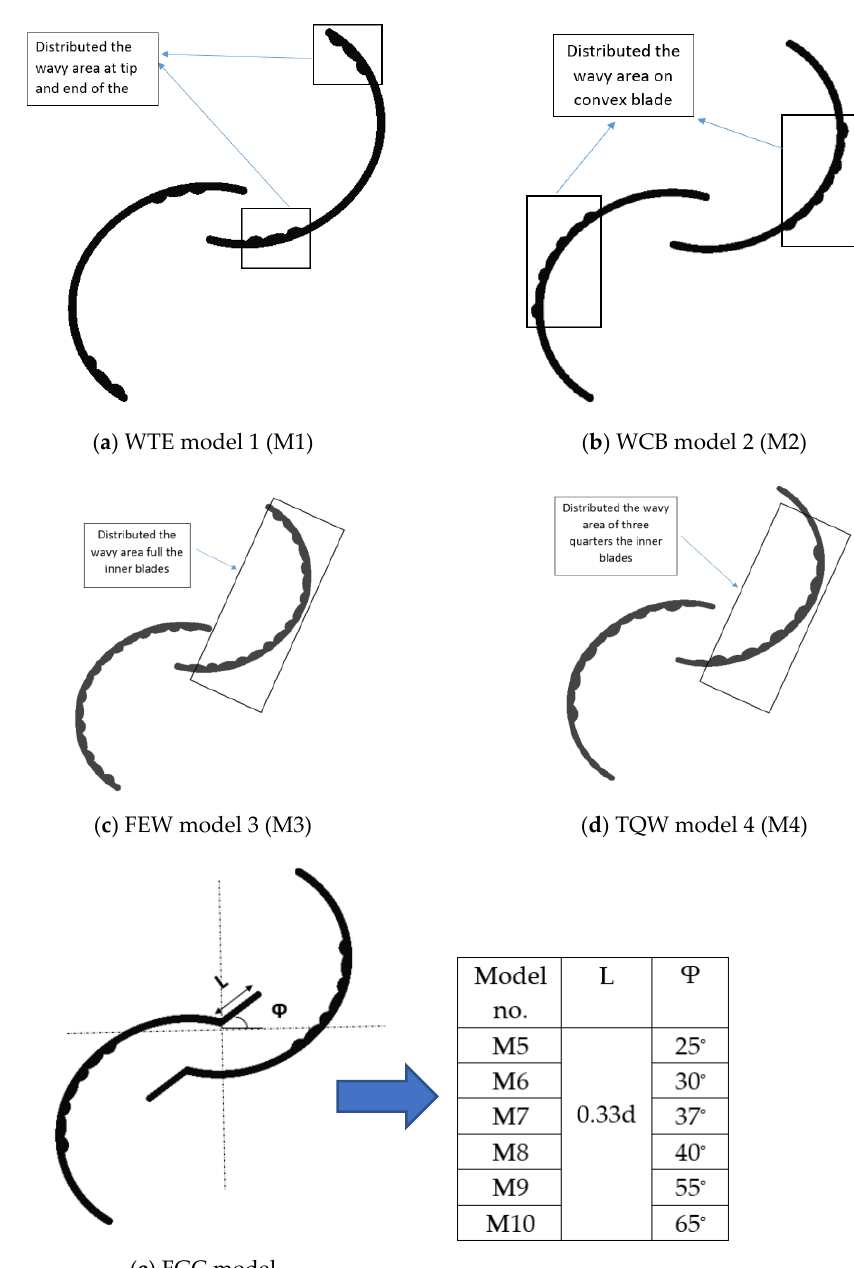
Figure 4. Rotor cross-sections of benchmark model and modified profiles.